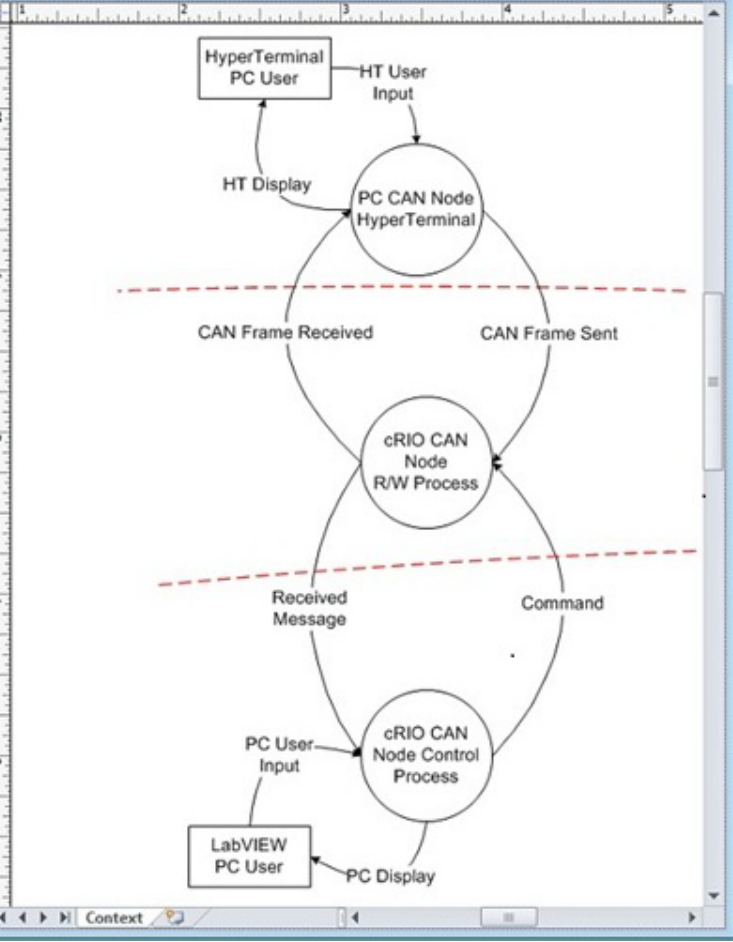
Figure 10. Representation of a CAN example in the modeling